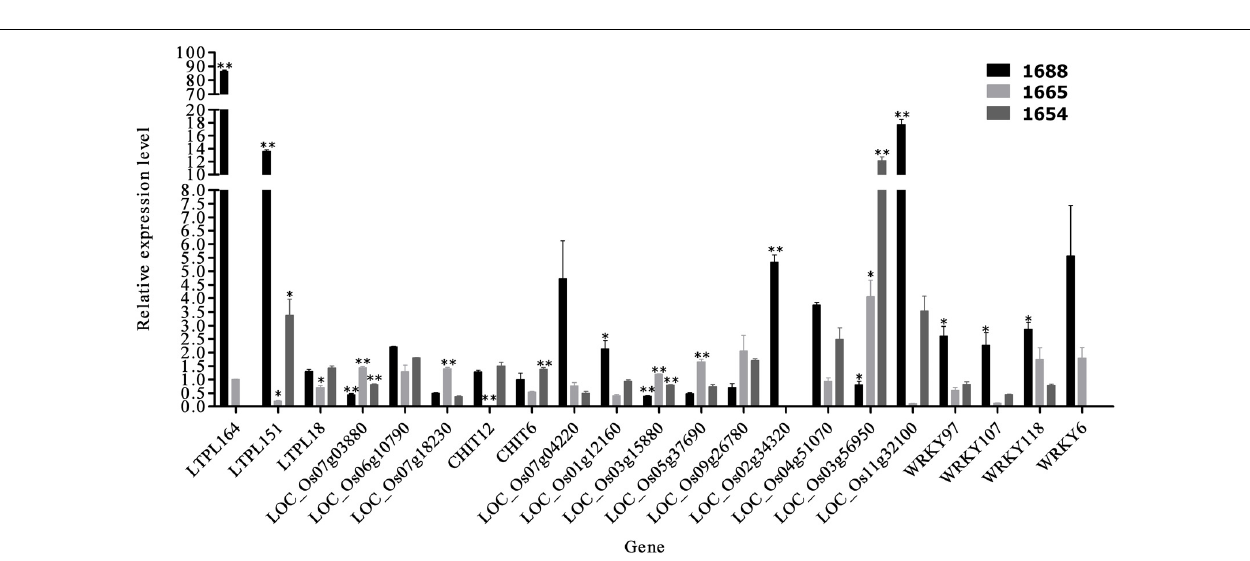
FIGURE 4 | The test results of RT-qPCR of 21 candidate genes. [21 candidate genes were analyzed by RT-qPCR. Relative expression levels of each gene were calculated using the 2– (cid:49)(cid:49) Ct algorithm. The software SPSS v17.0 (IBM Inc., Chicago) and the GraphPad prism 5 were used for data analyses and this figure. Then data are presented as mean fold change ± standard error (SE) and indicated by vertical bars ( ∗ P < 0.05, ∗∗ P < 0.01). The 18s rRNA was chosen as a housekeeping gene (F: 5 (cid:48) -atgataactcgacggatcgc-3 (cid:48) ; R: 5 (cid:48) -cttggatgtggtagccgttt-3 (cid:48)